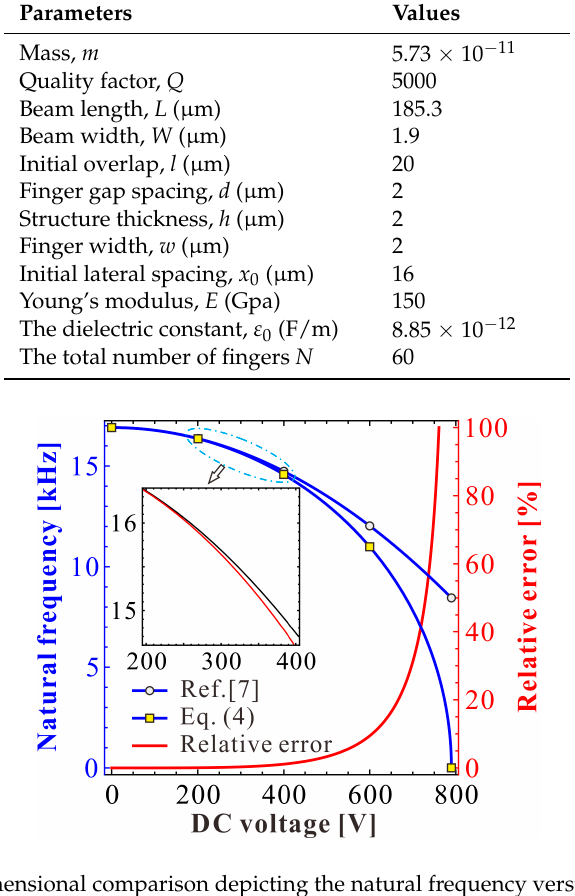
Figure 12. Frequency response curve with low energy corresponding to Figure 9. ( a )